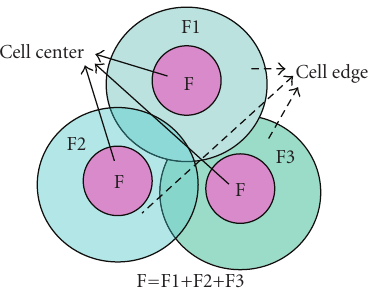
Figure 2: Vanilla FFR